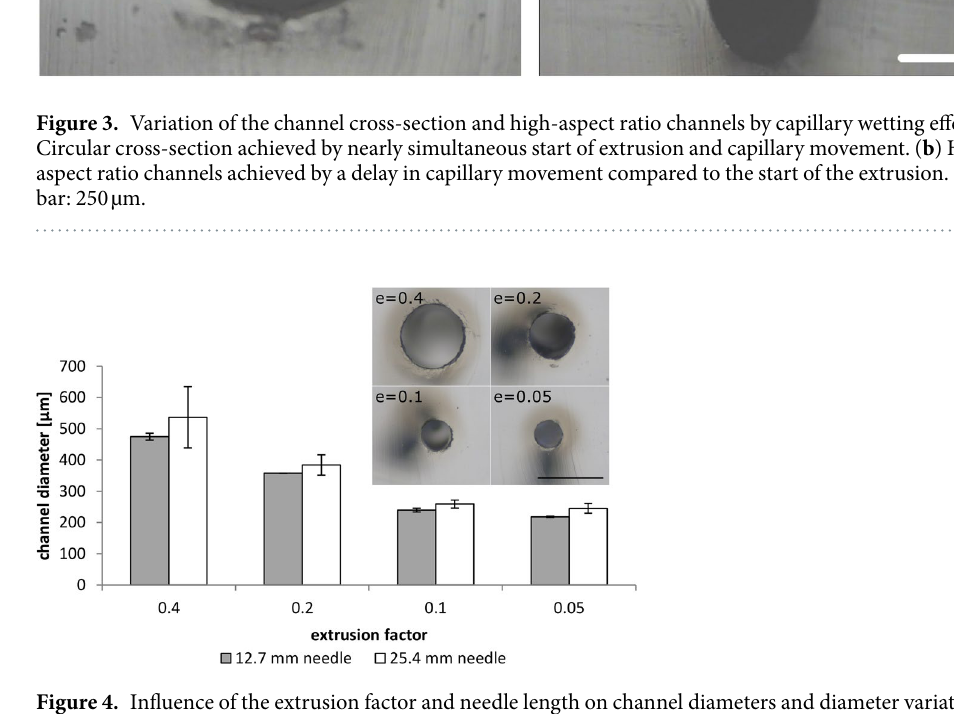
Figure 4. Influence of the extrusion factor and needle length on channel diameters and diameter variations. Diameter of channels printed at 50 mm/min with different extrusion factor settings and two different needle lengths (internal diameter of both needle types: 0.15 mm). Standard deviations of channel diameters are much higher when using a longer 25.4 mm (1 inch) needle. Inset: Channel diameters of channels printed at the different extrusion factor settings with the 12.7 mm (0.5 inch) needle, scale bar 500 µ